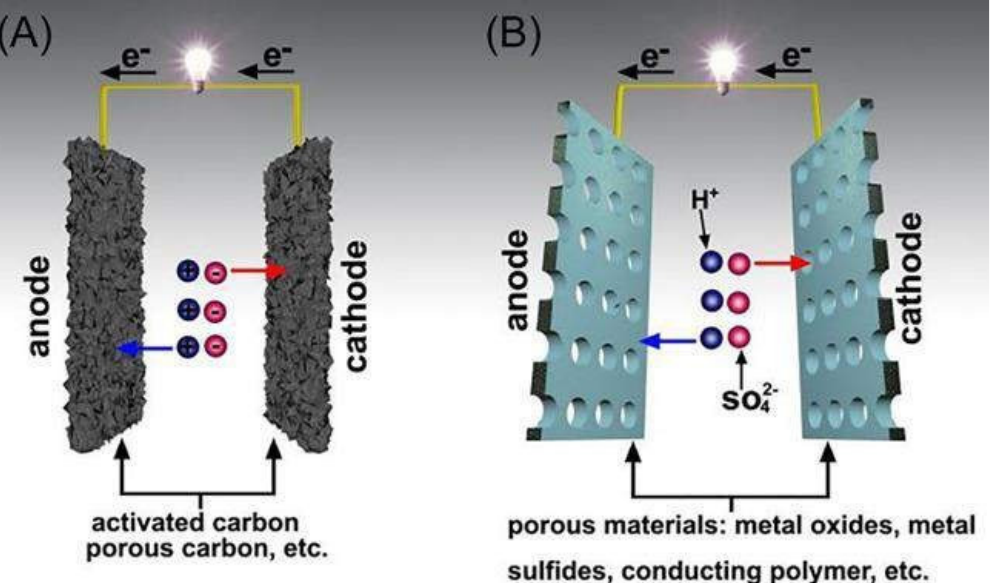
Figure 10. Schematic diagram of ( a ) an electrical double-layer capacitor (EDLC) and ( b ) a pseudocapacitor (PC). Reproduced with permission from [79].